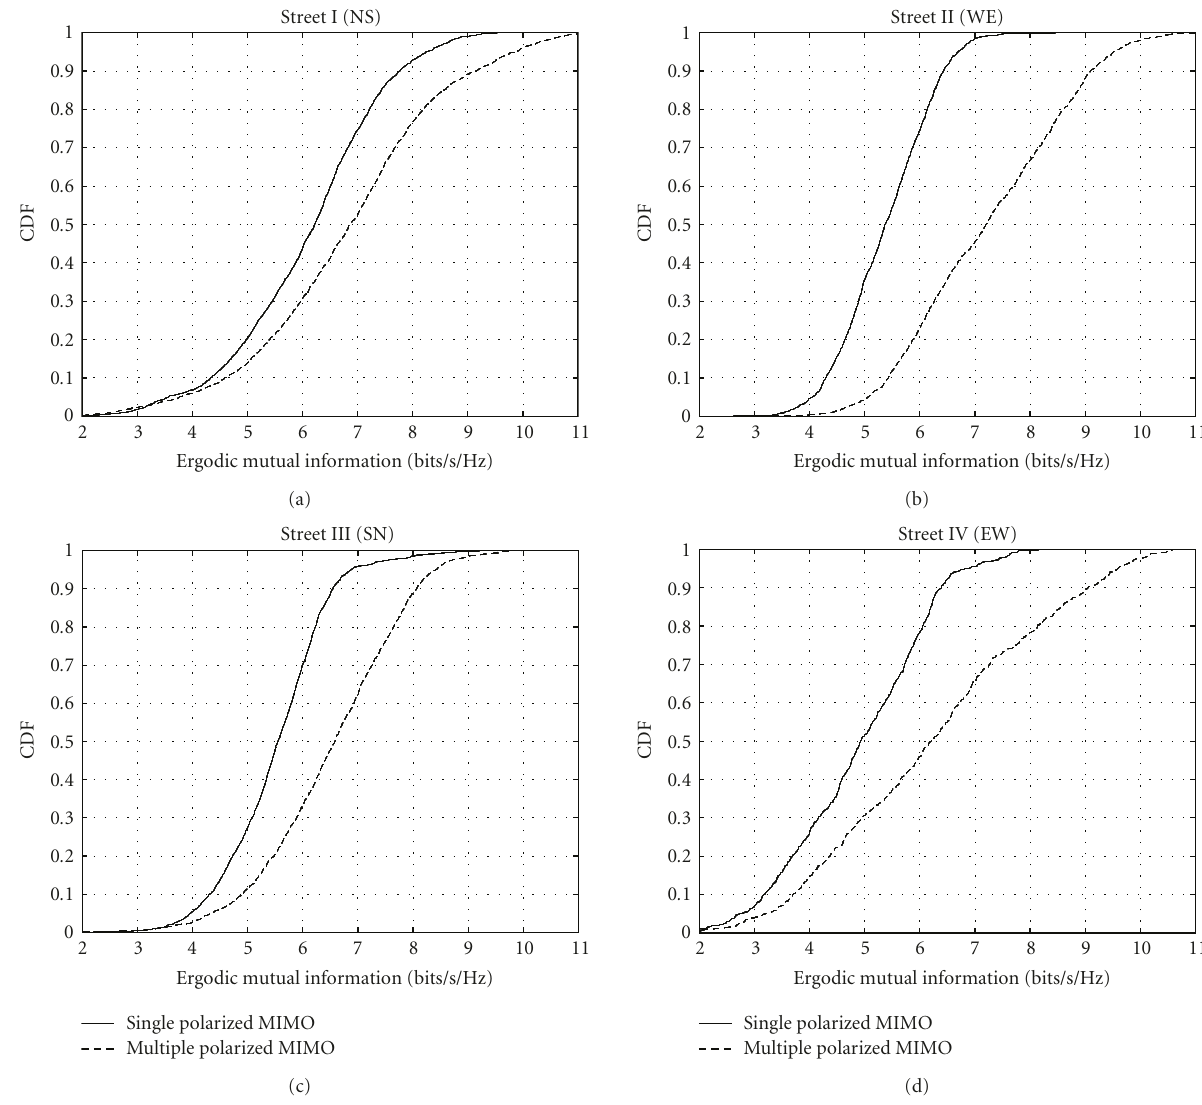
Figure 5: Ergodic mutual information of the single and multiple polarized MIMO